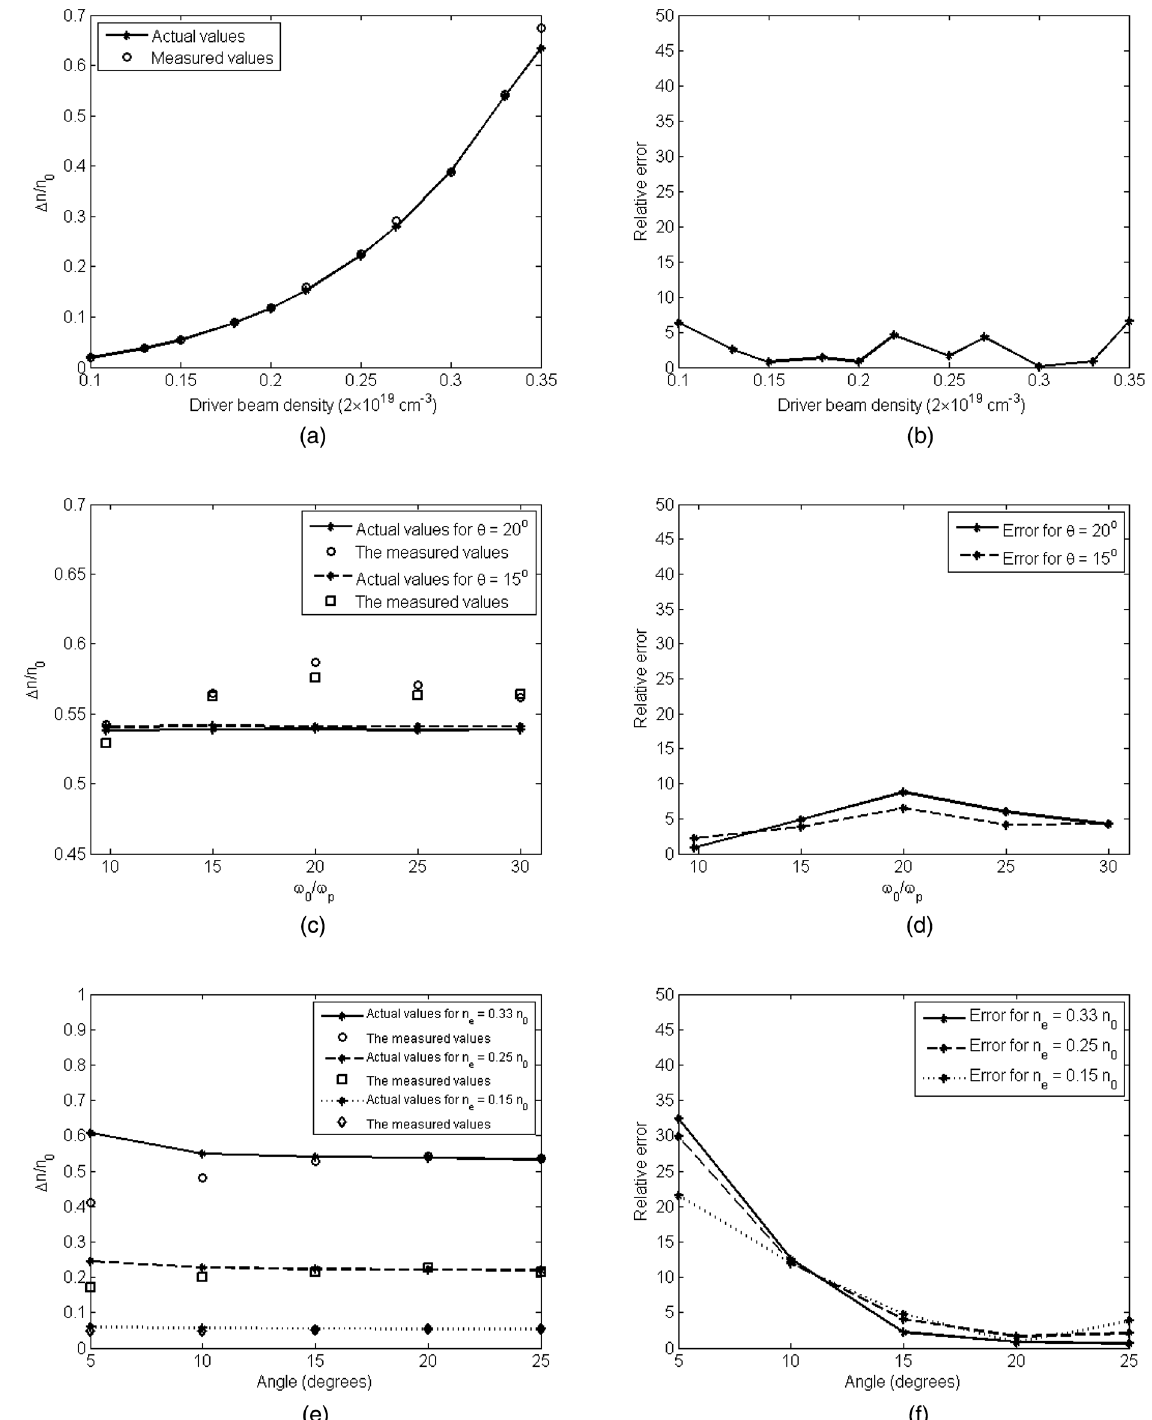
FIG. 6. Comparison of the measured and actual amplitude of the density modulation profiles for (a) various driver beam ’ s densities and (b) the relative errors; (c) various probe ’ s frequencies and (d) the errors; (e) various angles and (f) the errors. The measured values are calculated from the frequency modulation profiles of the laser probe pulse using Eq. (9). The actual values are obtained directly from the electron density modulation profiles in the